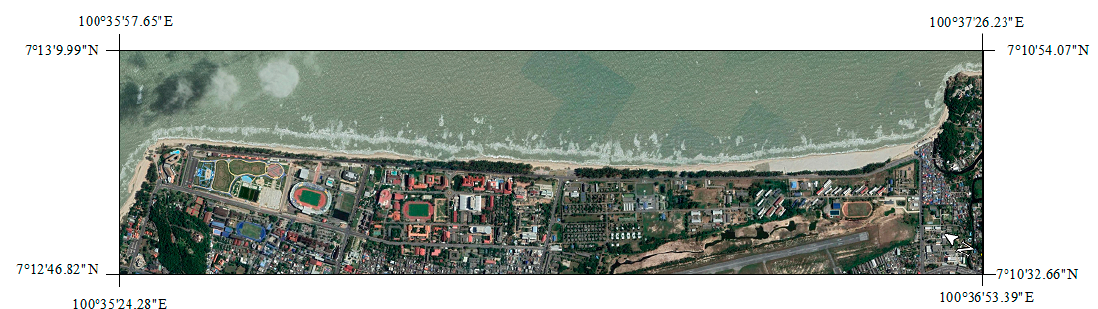
Figure 3. Survey sections of Chalatat beach. Table 3. Slope, sediment size of Chalatat beach.